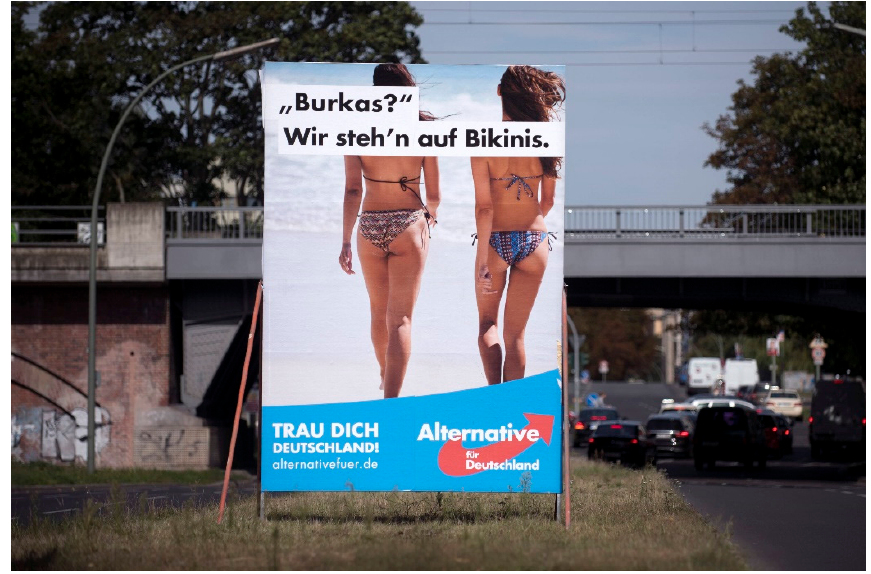
Figure 1. AfD election poster. Credit: imago images/IPON. Figure 1 uses bold, graphic text superimposed on a beach scene featuring three fe- male bodies in scanty bikinis. At the level of visual content (1), the visual style of female bodies wearing bikinis in the center of the poster recalls the sexualized marketization and